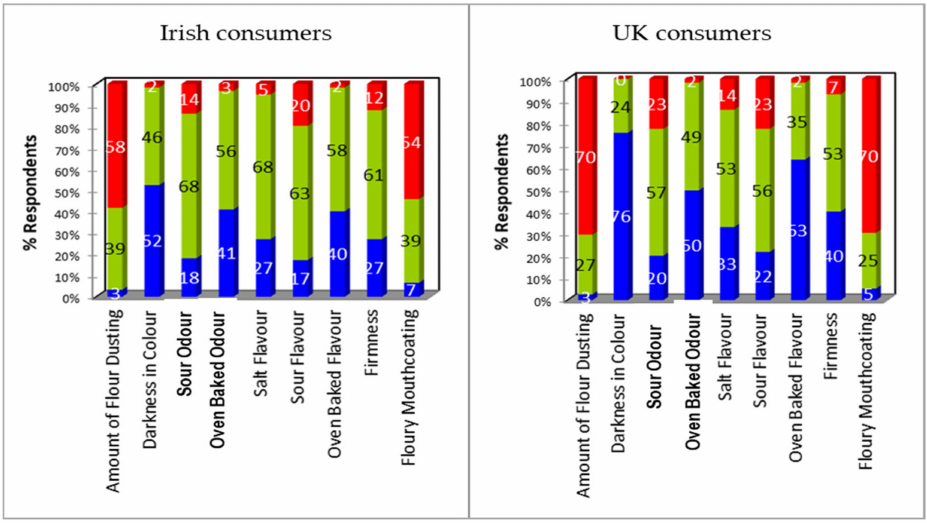
Figure 2. Deviation from ideal / just about right (JAR) for Blaa A from Irish and UK consumers. Data expressed as percent of responses from the collapsed JAR scale in which: Too little (blue) = rating of 1 + 2, Too much (red) = rating of 4 + 5, and Just right (green) = rating of